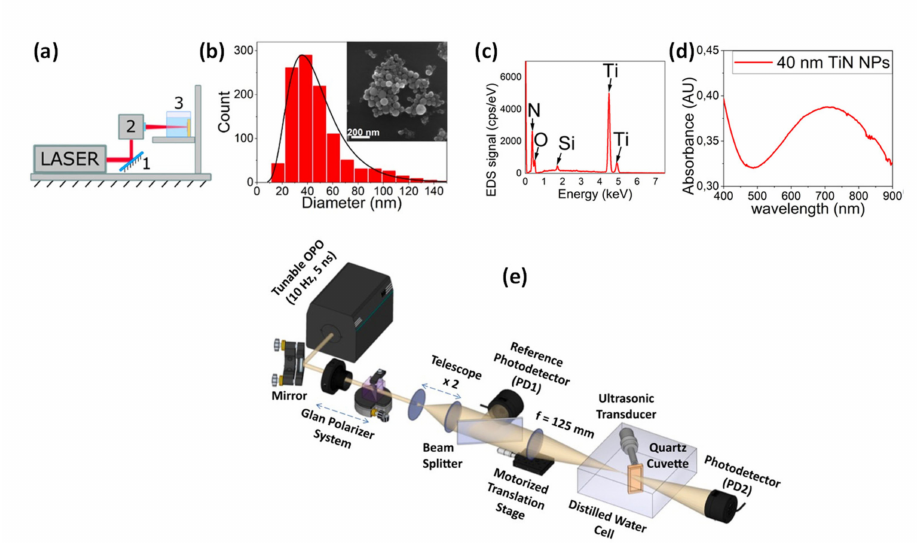
Figure 11. ( a ) Schematic of the fs laser ablation method; ( b ) Size distribution of TiN NP prepared by laser ablation; ( c ) EDS of the NP, identifying the NP contents; ( d ) Absorbance spectra of 40 nm TiN NP in acetone; ( e ) Experimental scheme for photoacoustic Z-scan. Reprinted with permission from ref. [85]. Copyright Optica Publishing Group, 2020.